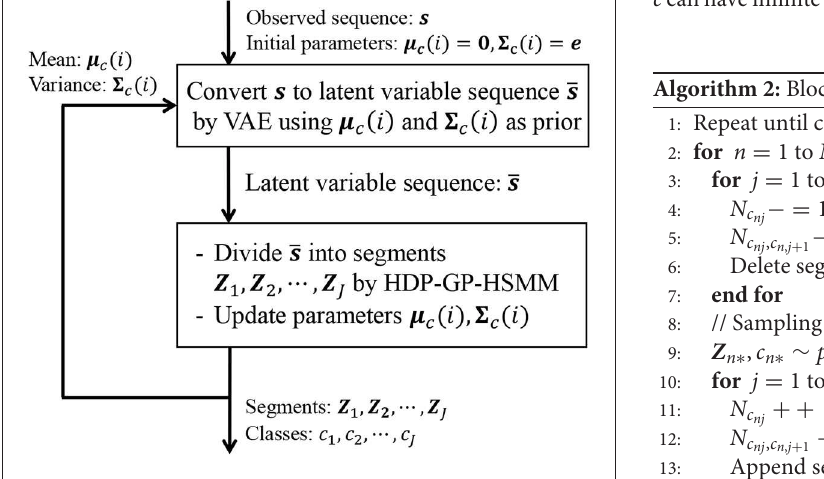
FIGURE 6 | Overview of parameter estimation for HVGH. The parameters are learned by a mutual learning loop of the VAE and